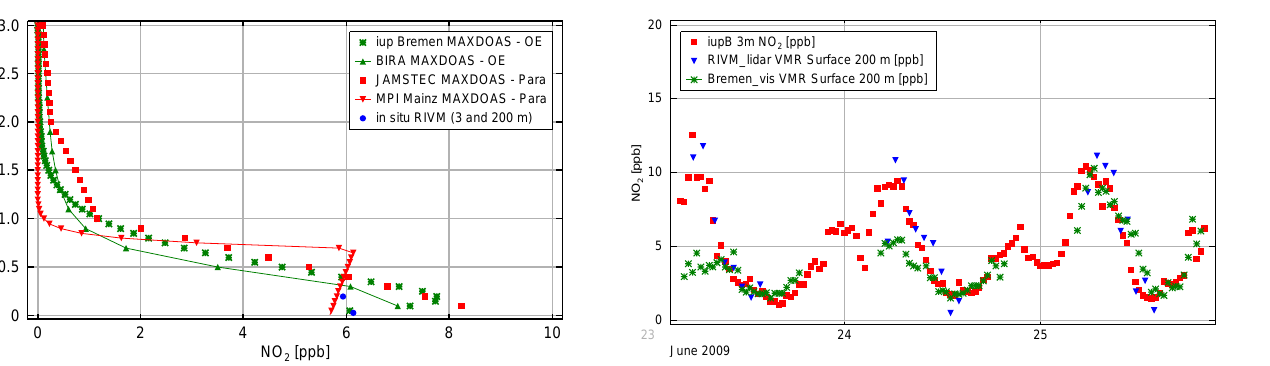
Fig. 15. NO 2 -profiles for 25 June 2009, 10:50UTC for four dif- ferent MAX-DOAS retrieval algorithms. In green are the profiles derived with the optimal estimation method, in red are the profiles derived with a simple parameterization method. In-situ data at 3 and 200m levels are indicated in blue.